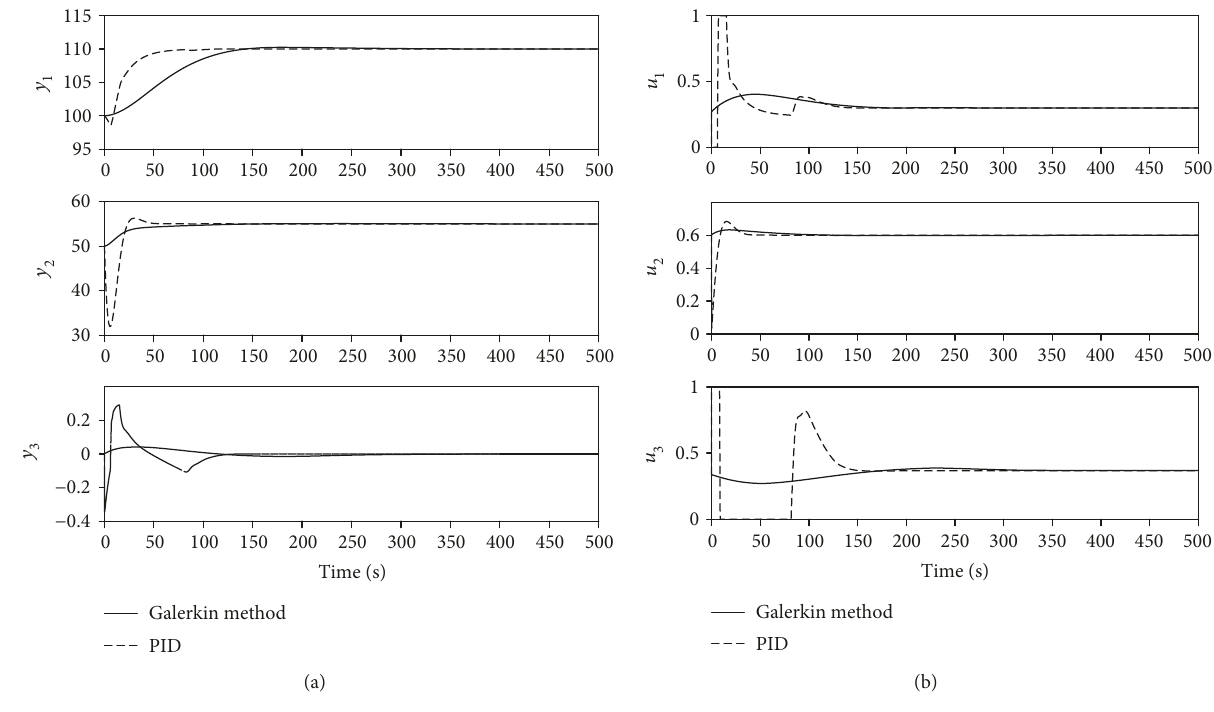
Figure 8: Outputs and controls of the unit by comparing with